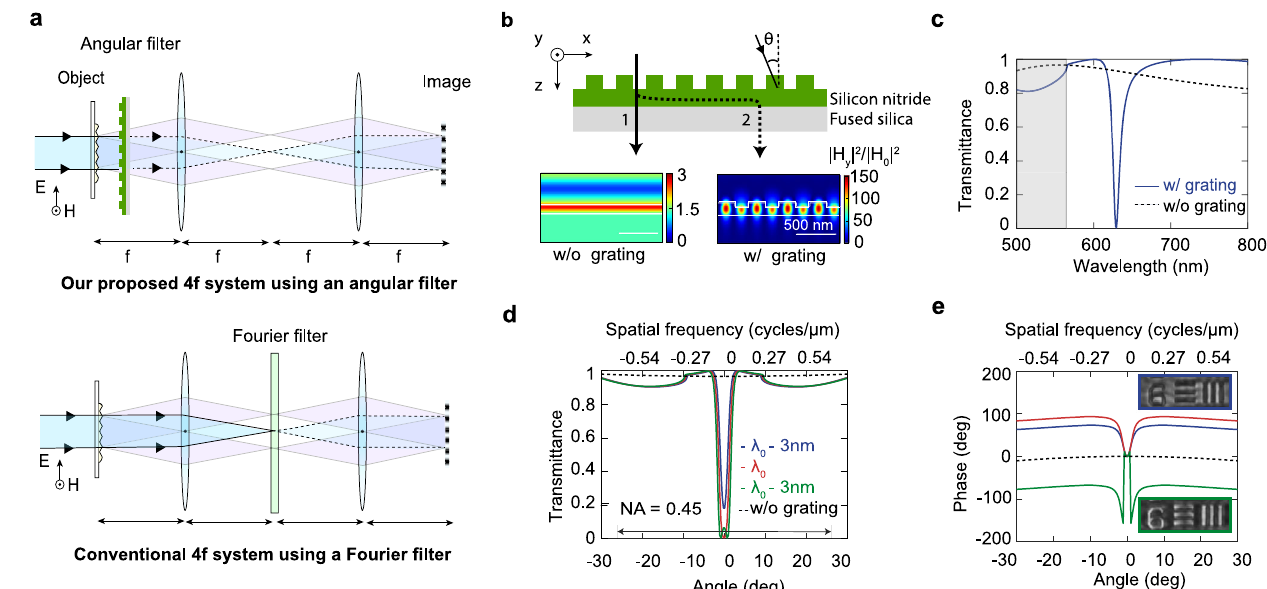
Fig. 2 | Optical image processing can be achieved with a NLM that serves as a designer angular fi lter. a Top: Our proposed phase contrast system utilizing an NLM-based angular fi lter. Bottom: A schematic of a conventional 4 f image pro- cessing system with a Fourier fi lter is shown for reference. b A cross sectional schematicoftheNLM.Incidenttransversemagnetic(TM)polarizedlightcantakea direct (1) and indirect, resonant pathway (2) through this optical element. The corresponding fi eld distributions are shown underneath the schematic. c The simulated transmittance spectrum of our NLM at normal incidence shows a